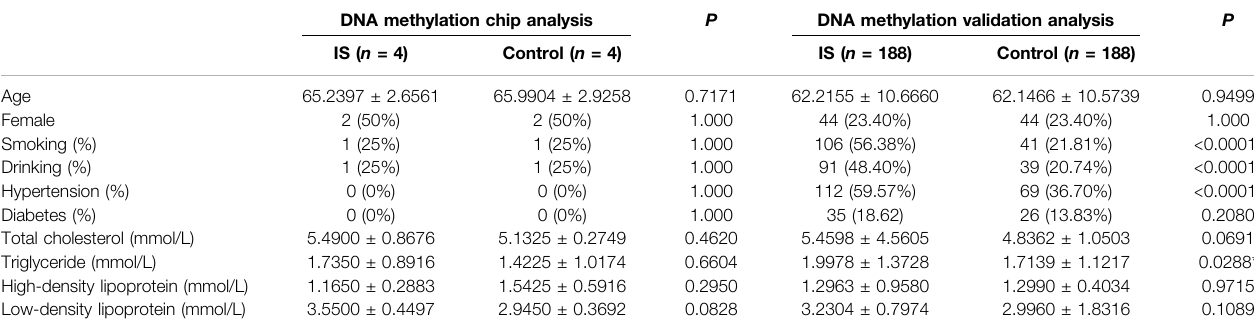
TABLE 1 | Characteristics of participants.